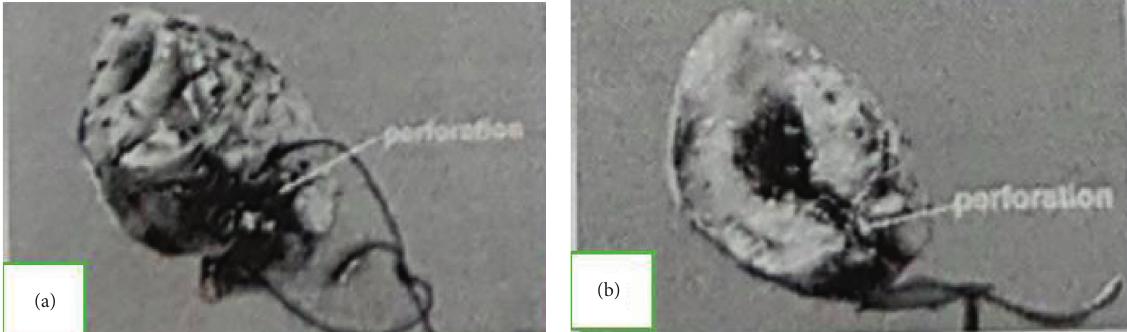
Figure 4: Gall bladder specimen: (a) perforated tract marked with a thread; (b) gall bladder section through the